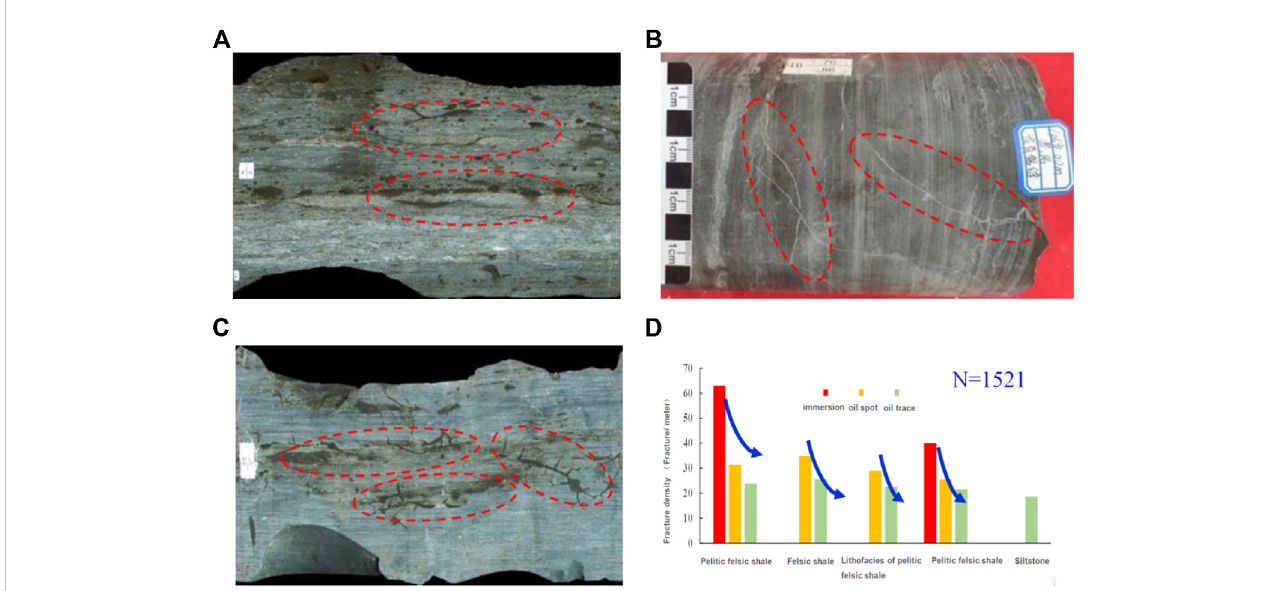
FIGURE 1 Core photos of Fengcheng Formation of Mahe north slope and Correlation between oil-bearing attribute and fracture density, (A) Clay shale, fracture fi lled with dolomite, (B) Clay shale, high angle oblique fracture, (C) dolomitic shale, map cracking, (D) Correlation between oil-bearing attribute and fracture density of Fengcheng